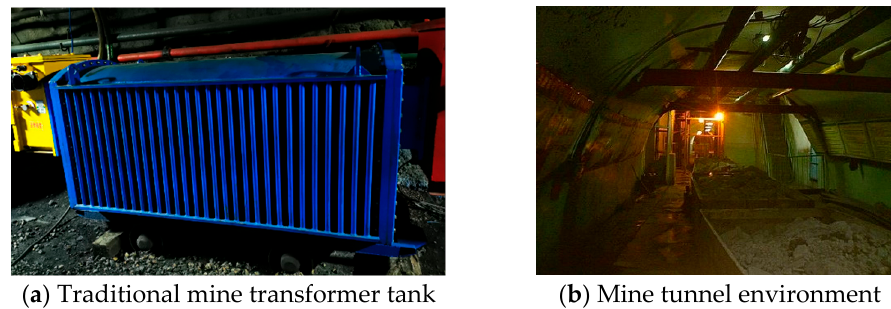
Figure 1. Environment of the mine tunnels and the conventional mine transformer.